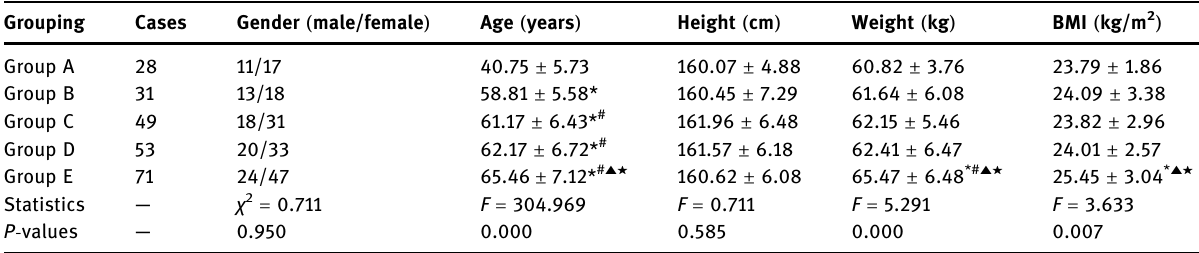
Table 1: Comparison of the general data of patients in di ff erent groups Grouping